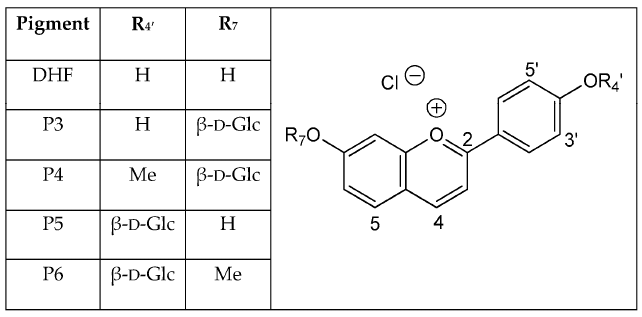
Figure 2. Pigments investigated in this work.